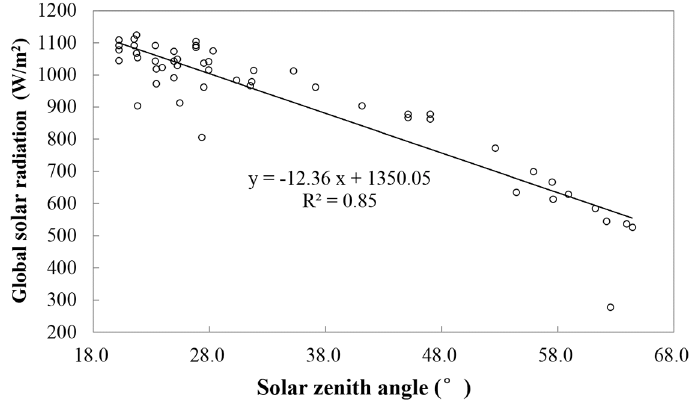
Figure 5. Scatterplot of ground-based DSSR measurements vs. the solar zenith angle at the S2A / B overpass